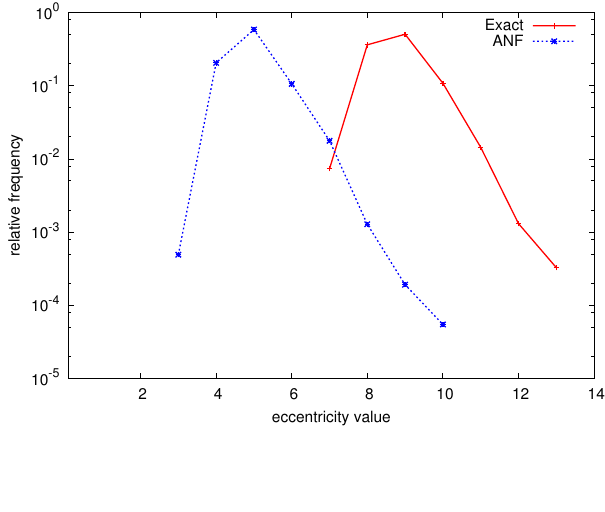
Figure 6. Exact and approximated relative eccentricity distribution of the E NRON